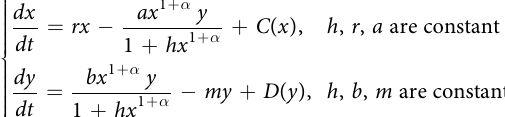
system (Fig. 3e, c,d = 0, refer to Supplementary Text in the Supplementary Information for the stability analysis). Moreover, the resulting dynamics of the LV systems (4) with type III functional responses and with/without small immigrants on the predator or prey population stabilizes the system (Fig. 4).